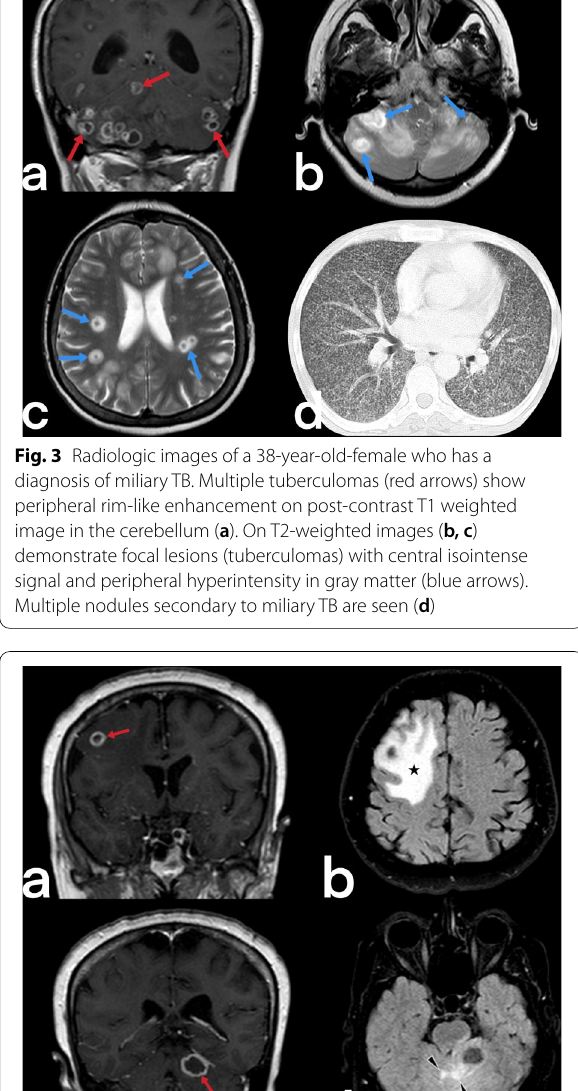
Spinal cord TB Spinal cord TB can be observed in cases of intramed- ullary myelitis, spinal meningitis, and arachnoiditis. It develops because of the direct spread of tuberculous spon- dylitis from the vicinity or hematogenous spread from the